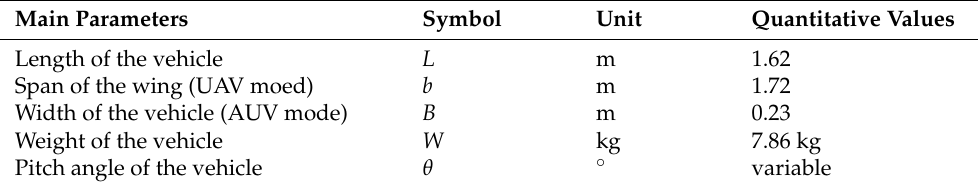
Table 1. Parameters of the object. Main Parameters Symbol Unit Quantitative Values Length of the